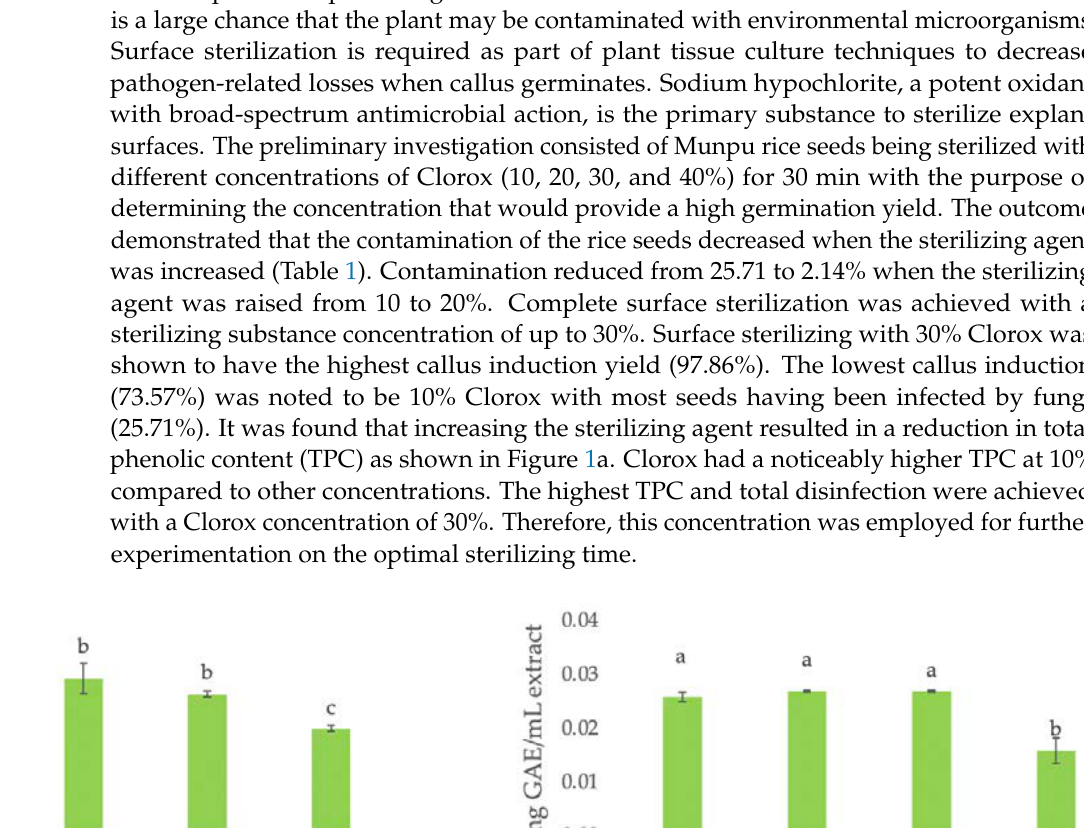
Table 1. Effect of Clorox concentration on rice callus induction.